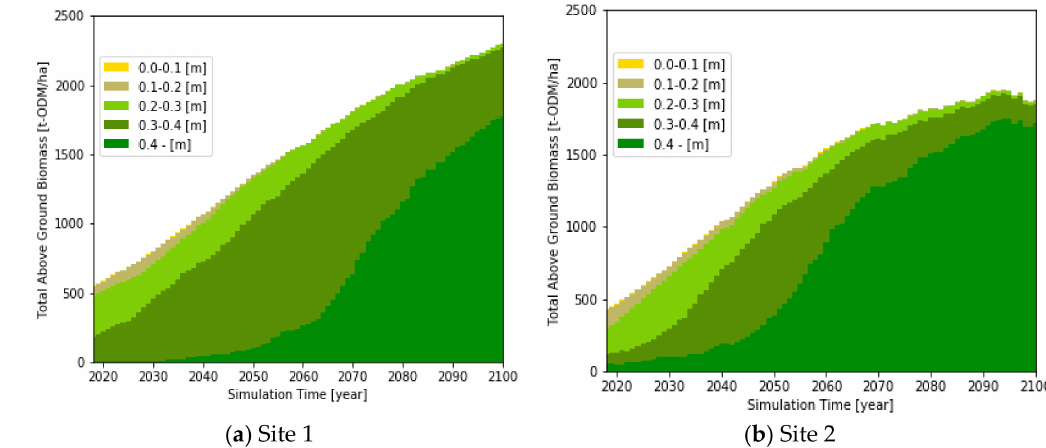
Figure 14. Above ground biomass estimation by DBH classes.